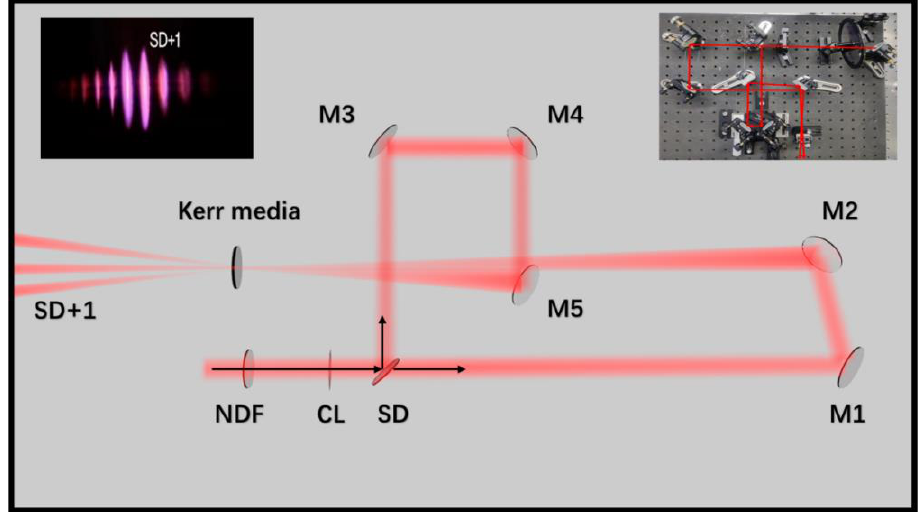
Figure 5. Experimental setup. Inset are pictures of the incident beams and the generated SD signals. NDF: variable neutral density filter; CL: cylinder mirror; BS: 1 mm-thick beam splitter; M1–M5: reflective plane